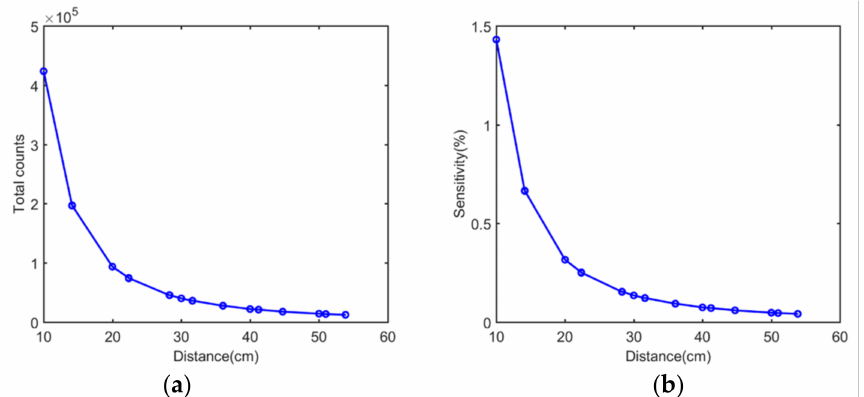
Figure 10. Simulated results of ( a ) events number plot versus distance and ( b ) sensitivity plot versus distance.